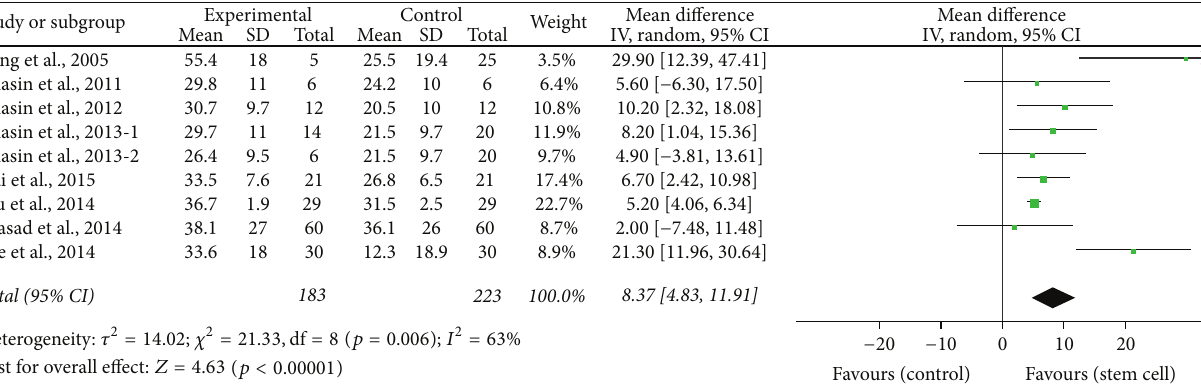
Figure 4: The effect size of Barthel index improvement across studies by meta-analysis.